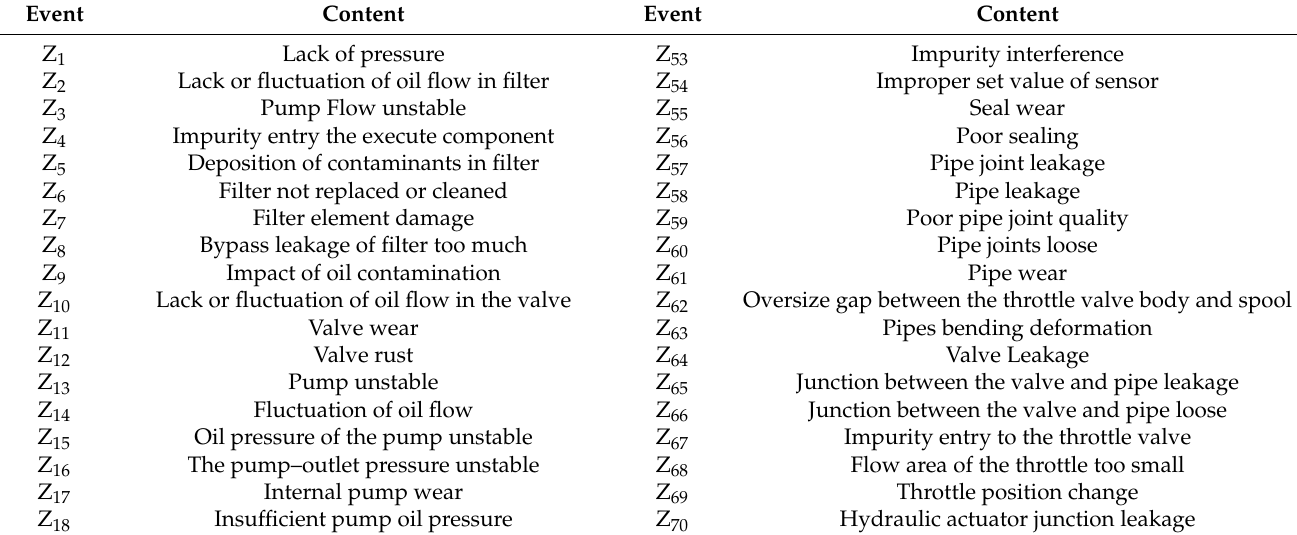
Figure 10. Fault tree of a hydraulic system: sub-tree VIII. Table 6. Events in the fault